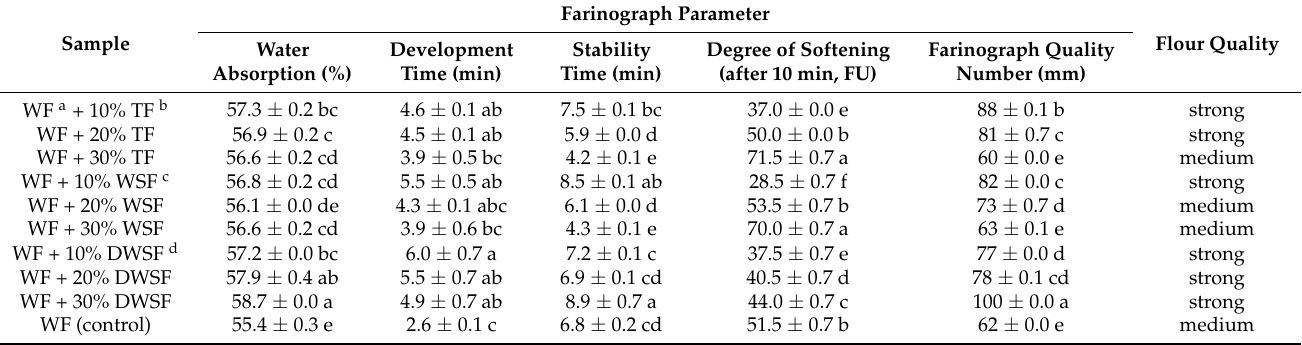
Table 6. Rheological properties of dough based on wheat flour with the addition of teff and water- melon seed flours (test levels: 10%, 20% and 30% w / w ). (mean ± SD). Farinograph